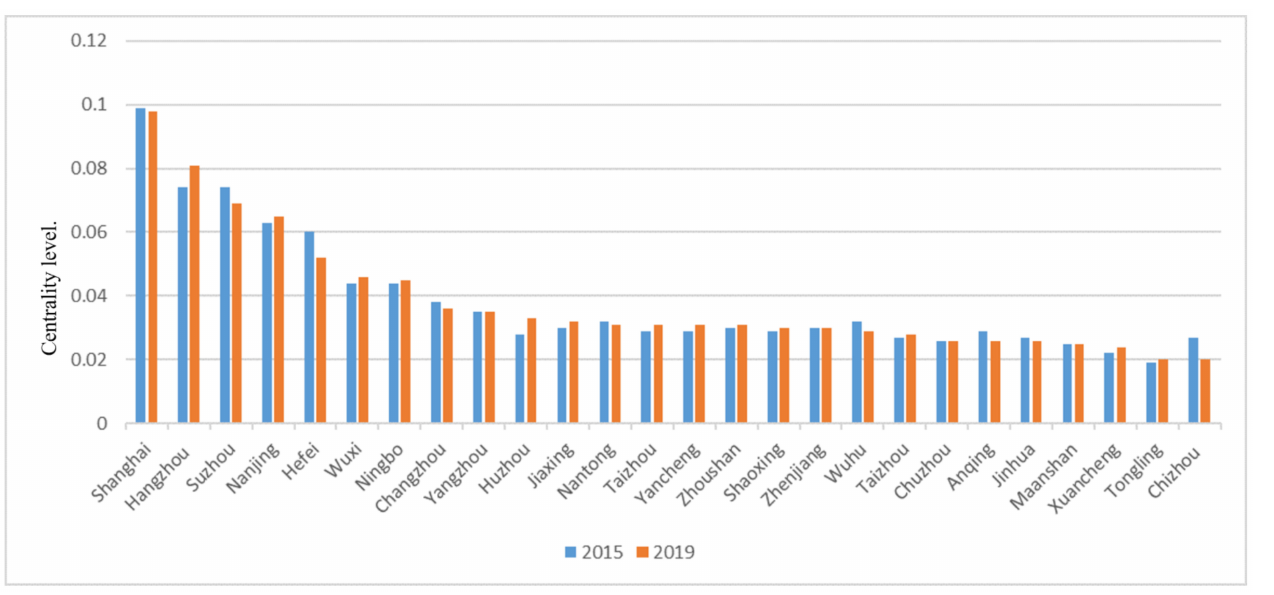
Figure 8. Centrality